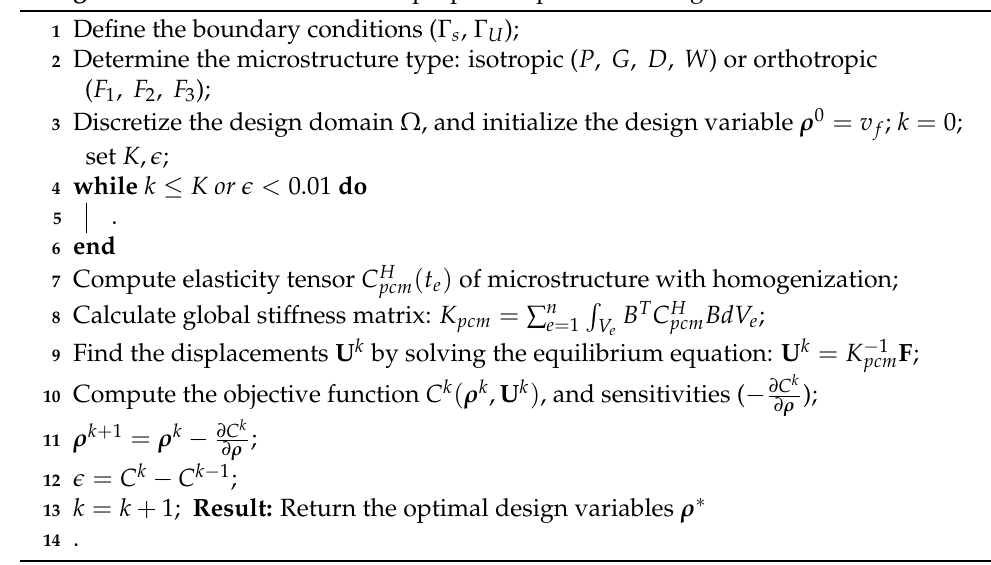
Algorithm 1: Pseudo-code of the proposed optimization